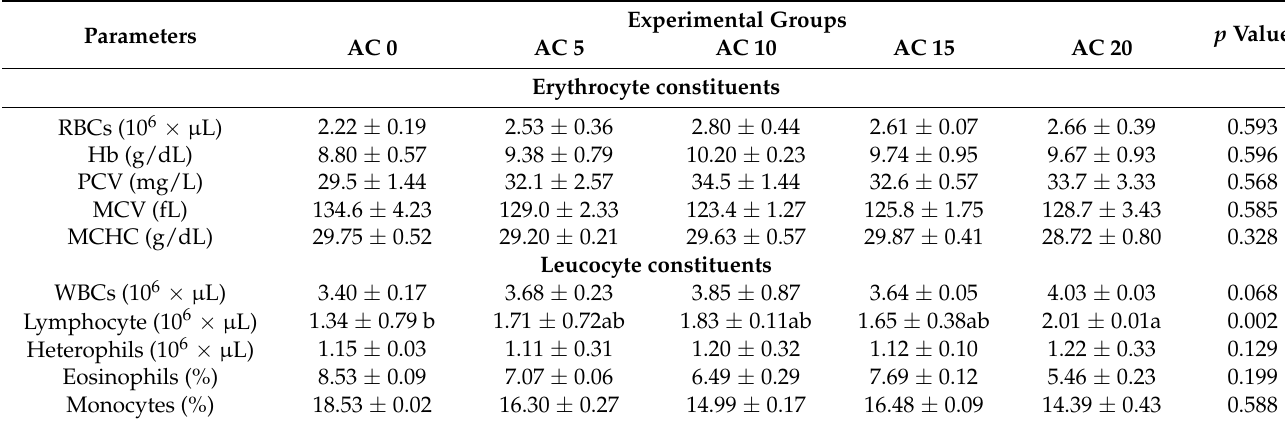
Table 3. Hematological profile of Nile tilapia fed diets supplemented with graded, activated charcoal (AC) levels for 8 weeks.